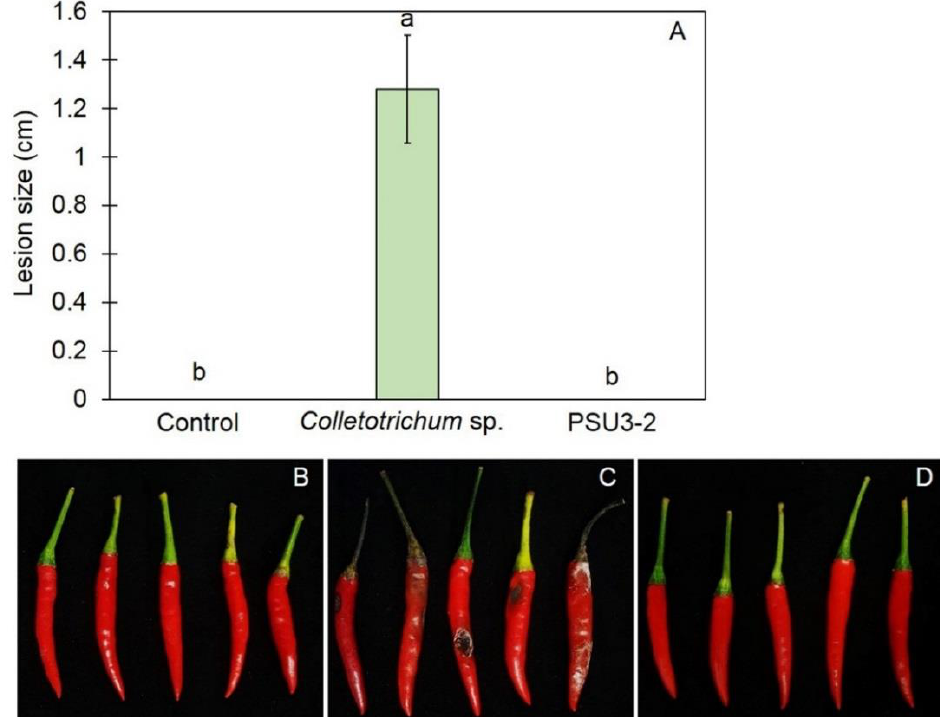
Figure 5. ( A ) Lesion sizes developed after inoculation with Colletorichum sp.; ( B ) chili pepper fruit inoculated with distilled water alone; ( C ) chili pepper fruit inoculated with Colletorichum sp. alone; ( D ) chili pepper fruit challenge inoculation with T. koningiopsis PSU3-2 and Colletorichum sp. Different letters indicate statistically significant differences among treatments ( p < 0.05) using Tukey’s test.